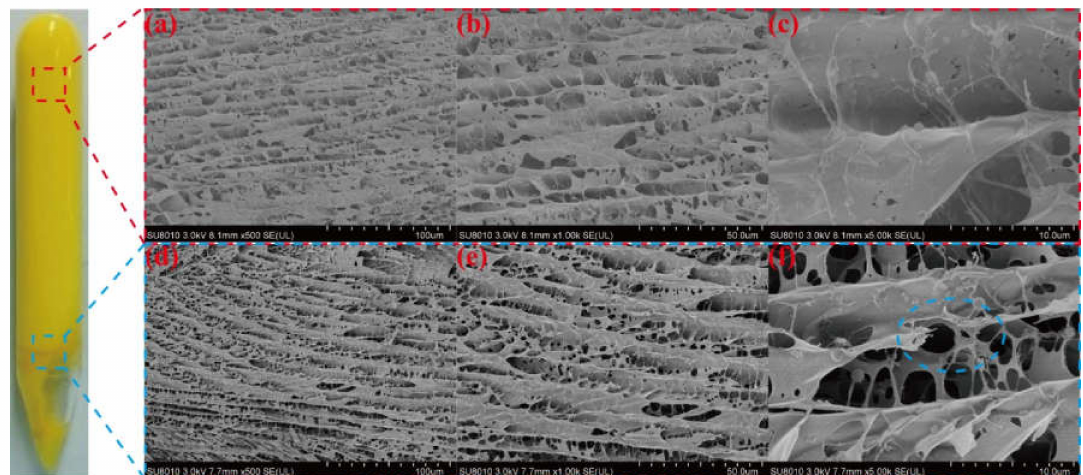
Figure 12. Cryo-SEM images of different parts of early dehydrated gels: microstructure of the gel at the bottom of the ampoule: ( a ) × 500, ( b ) × 1.00 k, and ( c ) × 5.00 k; microstructure of the gel on top of the ampoule: ( d ) × 500, ( e ) × 1.00 k, and ( f ) × 5.00 k.